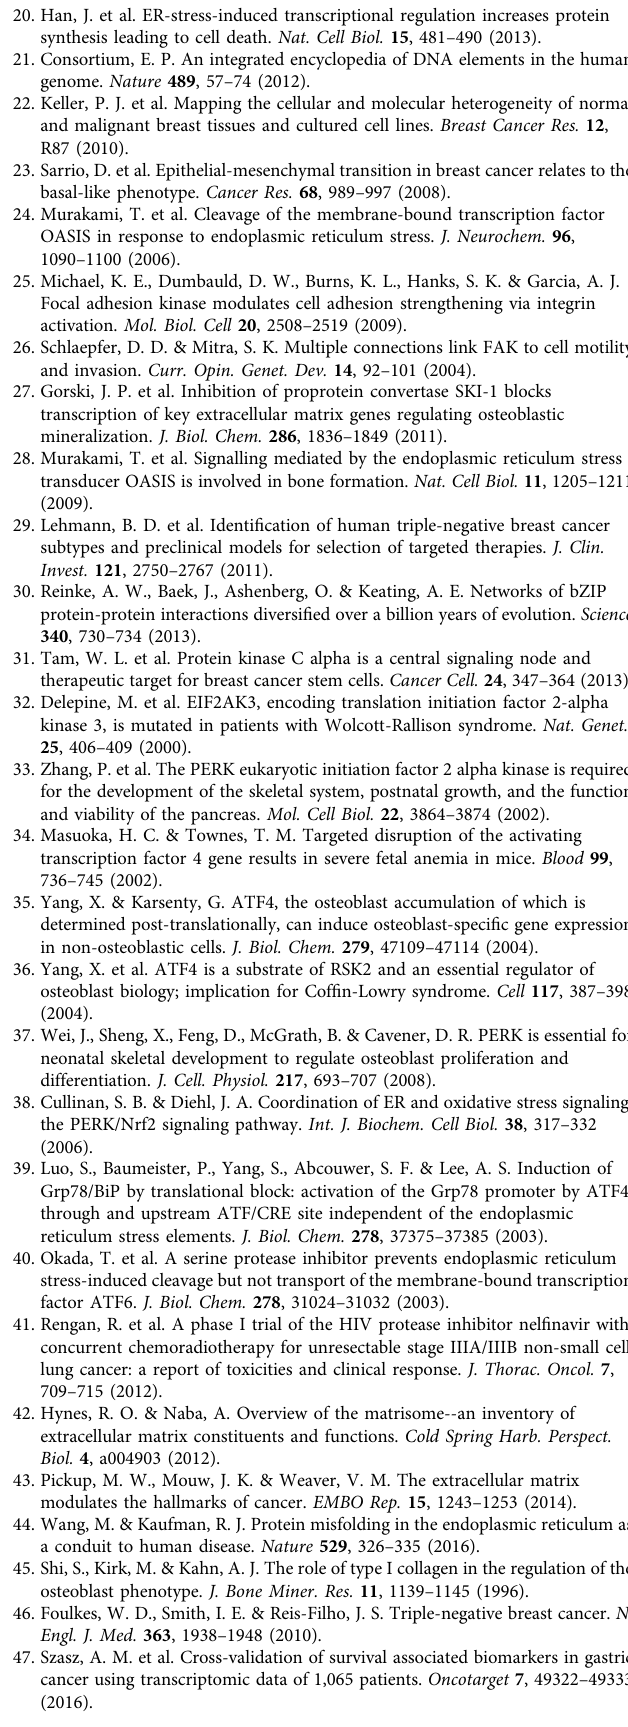
those in the bottom tertile for the signature score. Data were plotted as a Kaplan – Meier